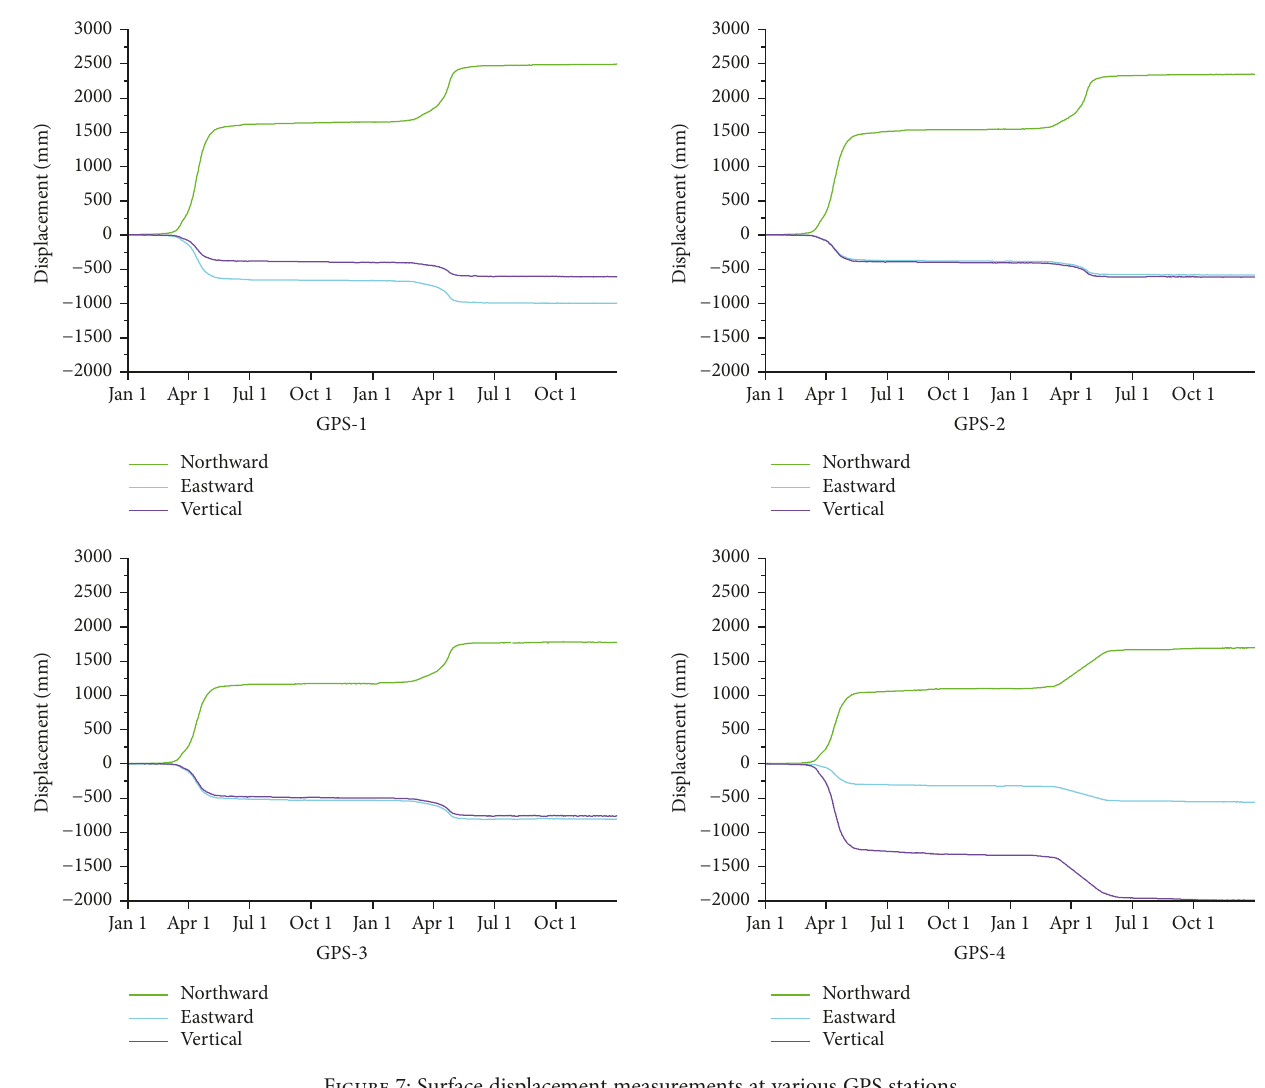
Figure 7: Surface displacement measurements at various GPS